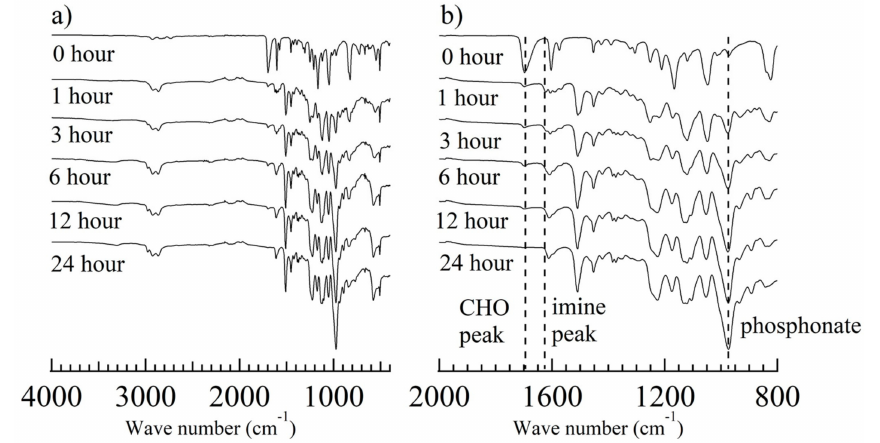
Figure 4. ATR-FTIR spectra (( a ) 400–4000 cm − 1 , and ( b ) 800–2000 cm − 1 ) of the ETFE- g -PSt-CHO (grafting time: 3 h) before and after the KF-3CR with 15-C-5-Ar-NH 2 and diisopropyl